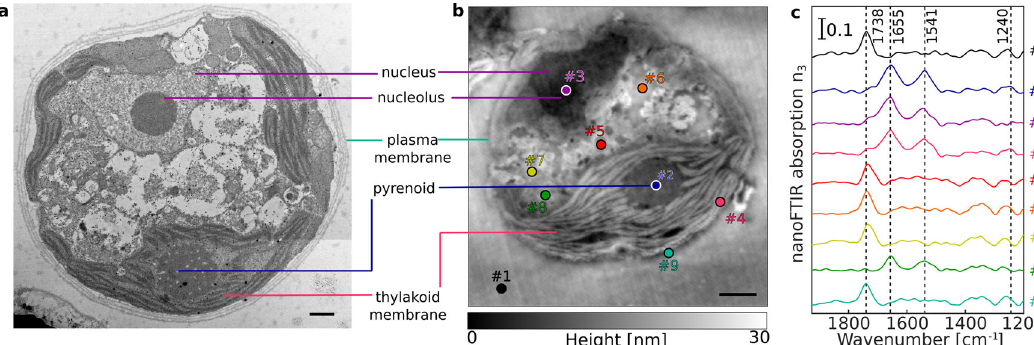
Fig. 2 Cross-sectional imaging of C. reinhardtii cells. Cellular cross sections were imaged by TEM ( a ) and AFM ( b ). Scale bars equal 1 µ m. nanoFTIR absorption spectra ( c ) were acquired at nine different locations marked on the